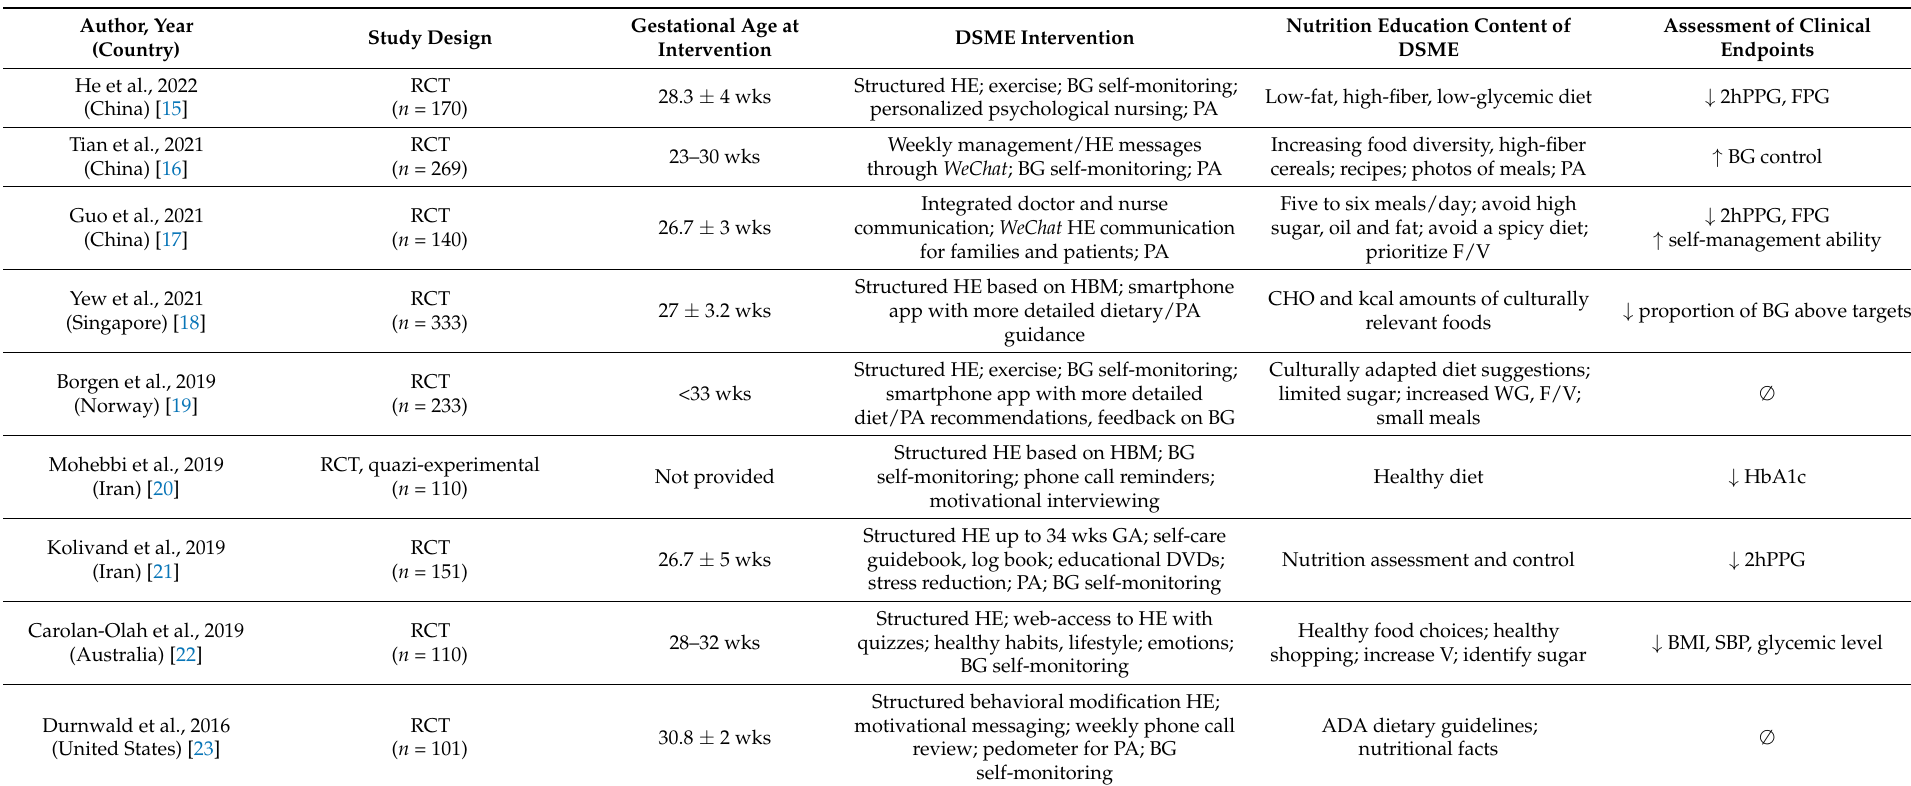
Table 1. Studies measuring the outcomes of diabetes self-management education in women with gestational diabetes